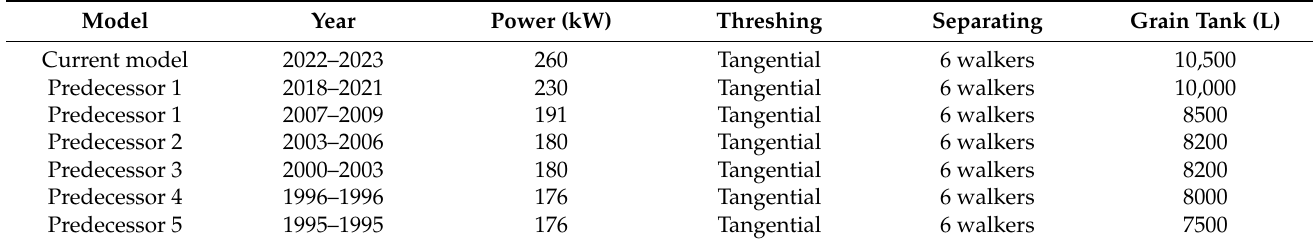
Table 2. Model genealogy sample.